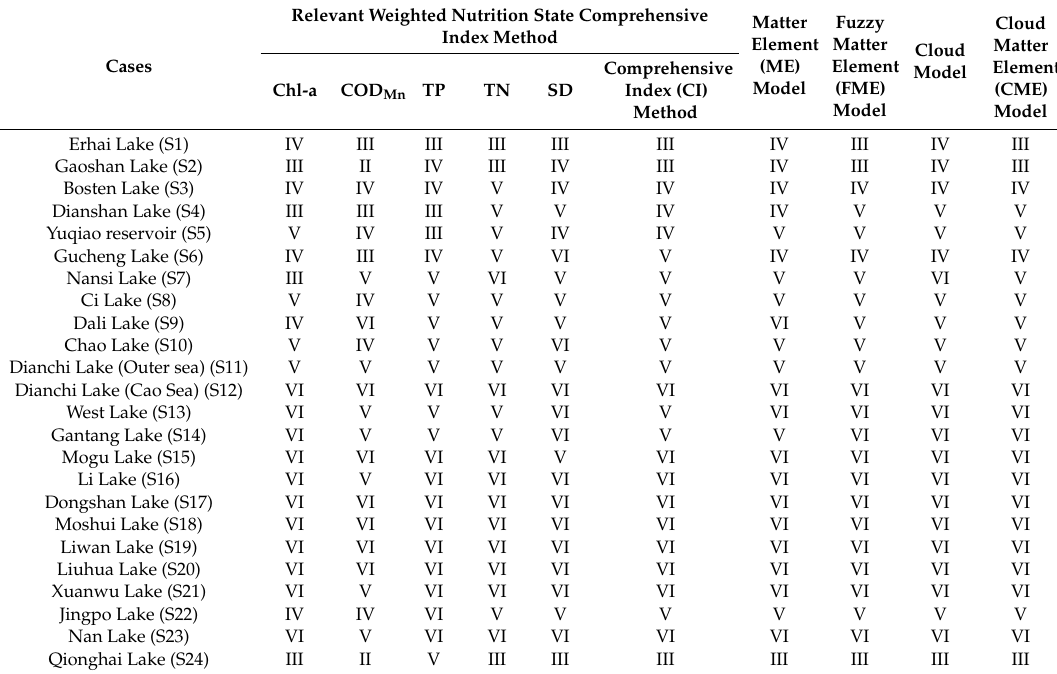
Table 6. Comparison of eutrophication level through various